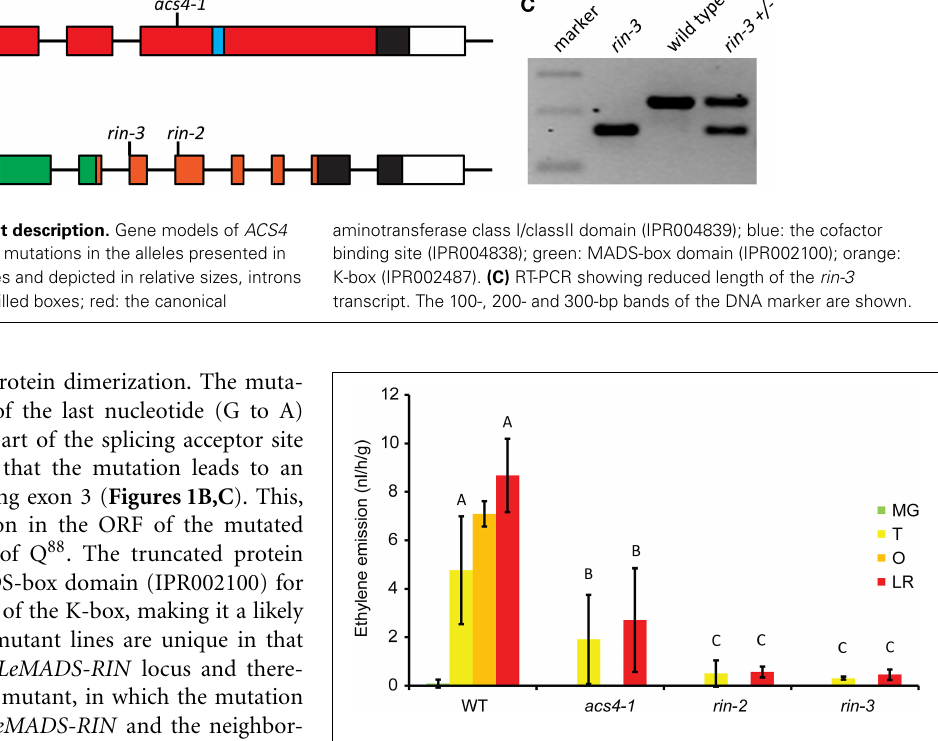
FIGURE 2 | Ethylene emission from fruits. The graph shows ethylene emission levels at four ripening stages in the wild-type and at two ripening stages in the mutants. Values represent the average of 3 plants (4–6 fruits per plant), ± SD . For statistical analysis, ethylene emissions were compared among the same developmental stage, with different letter indicating a significant difference of at least P < 0 .